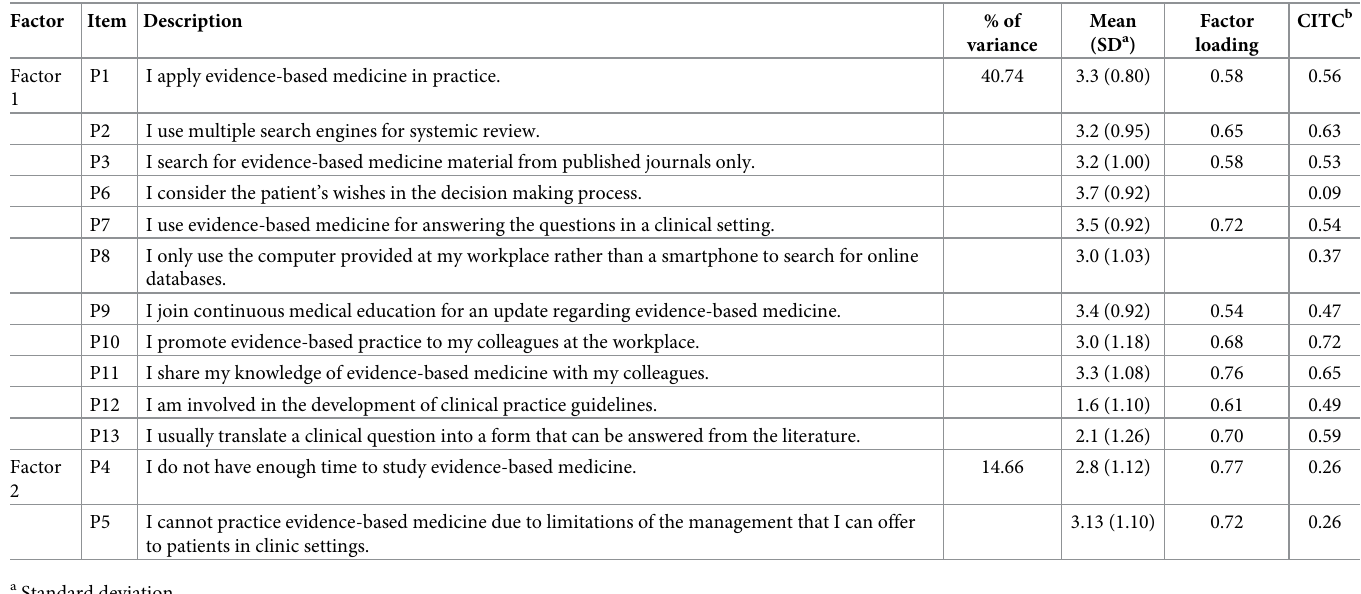
Table 3. Psychometric properties of practice domain for EBM. Factor Item